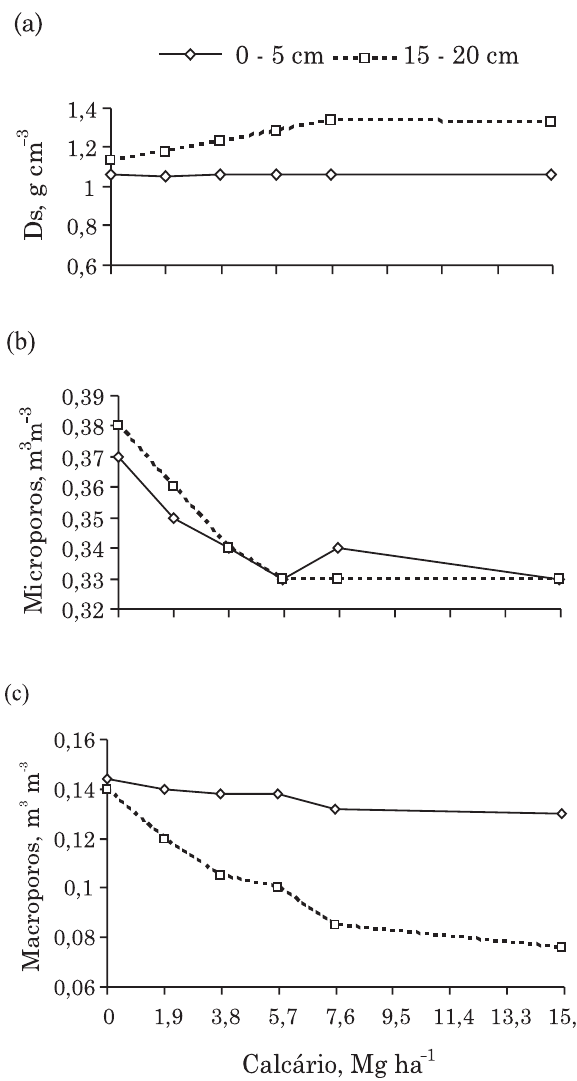
Figura 1. Valores de (a) densidade (Ds), (b) micro e (c) macroporosidade de duas camadas de solo incubado com doses de